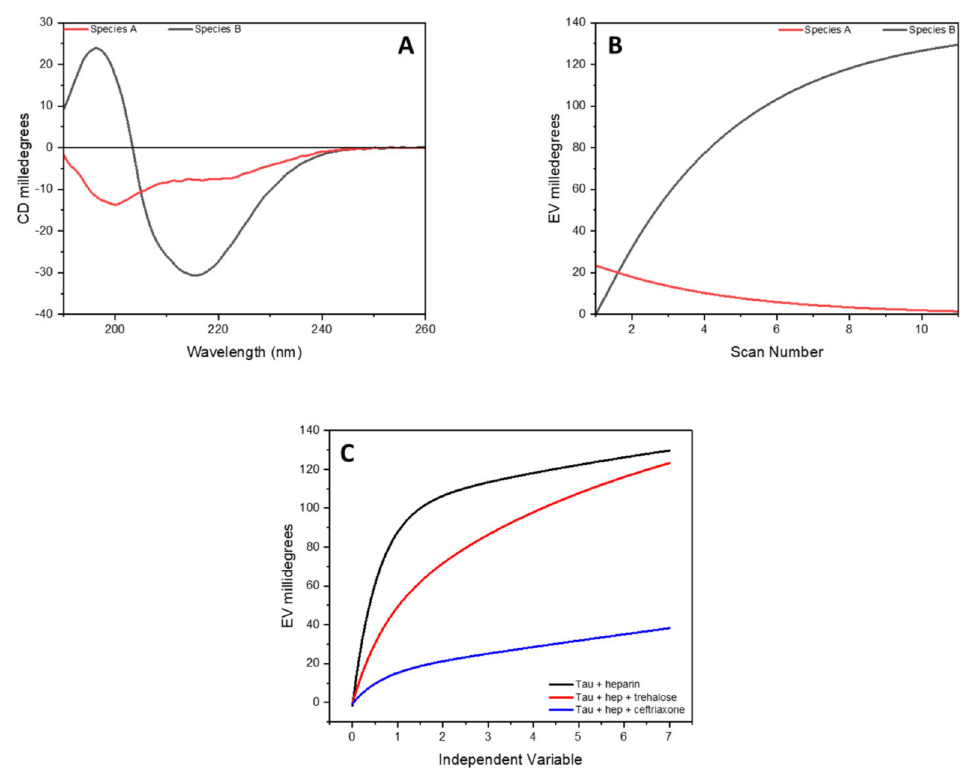
Figure 4. SVD analysis of complete data set of CD spectra of tau peptide for the conformational conversion of peptide induced by low-molecular-weight heparin. ( A ) CD spectra of the initial (specie A, in red) and final (specie B, in black) conformation of tau peptide in presence of 0.25 equivalents of heparin; ( B ) the time-dependent amplitude of the two species of tau peptide; ( C ) influence of trehalose or ceftriaxone on the conformational conversion of tau peptide induced by heparin. To assess whether trehalose or ceftriaxone could interfere with or modulate the con- formational conversion of tau peptide from unordered to β -sheet induced by heparin,